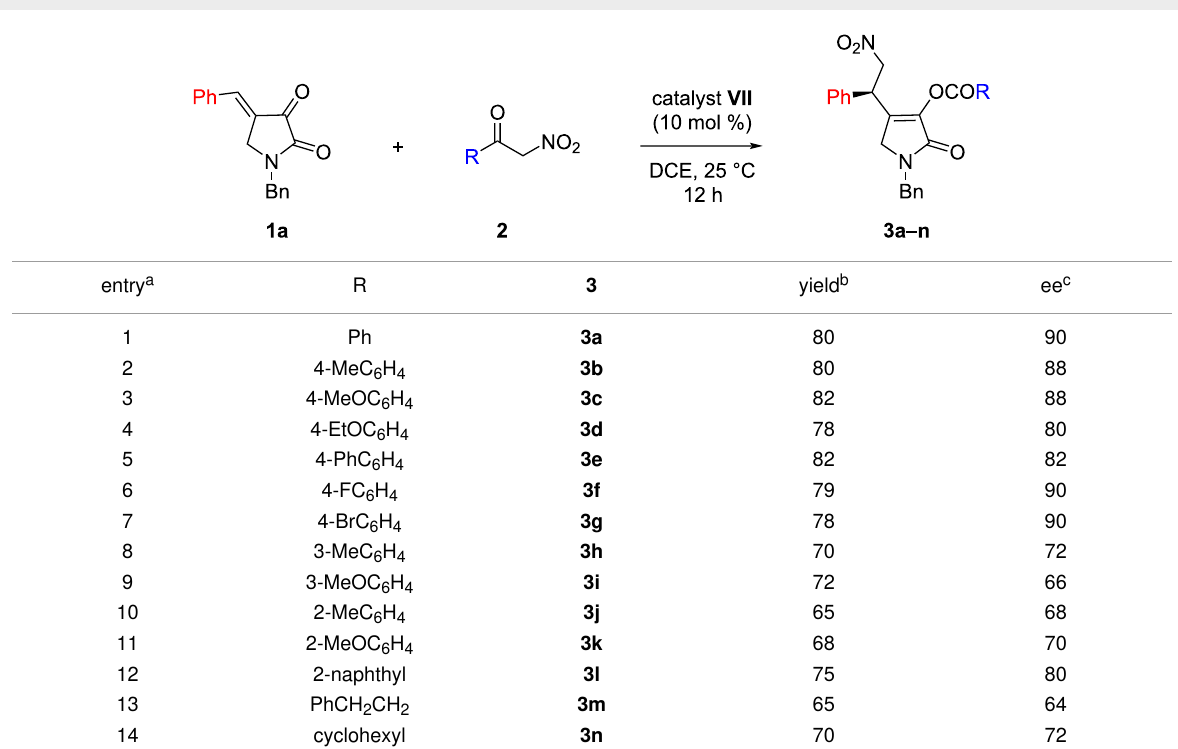
Table 2: Scope of α -nitroketones 2 in the reaction with 1a .